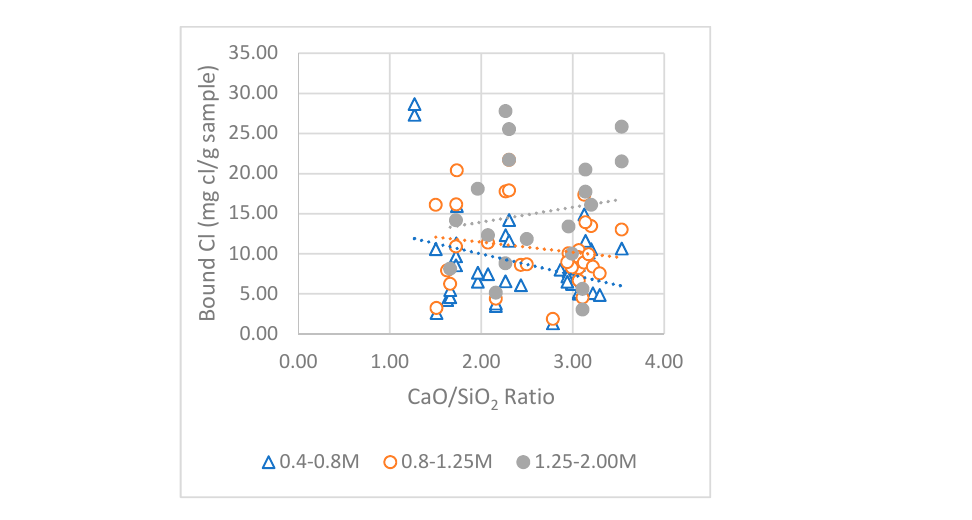
Figure 12. Relation between CaO/SiO 2 ratio and bound chloride for different chloride concentrations for all data.